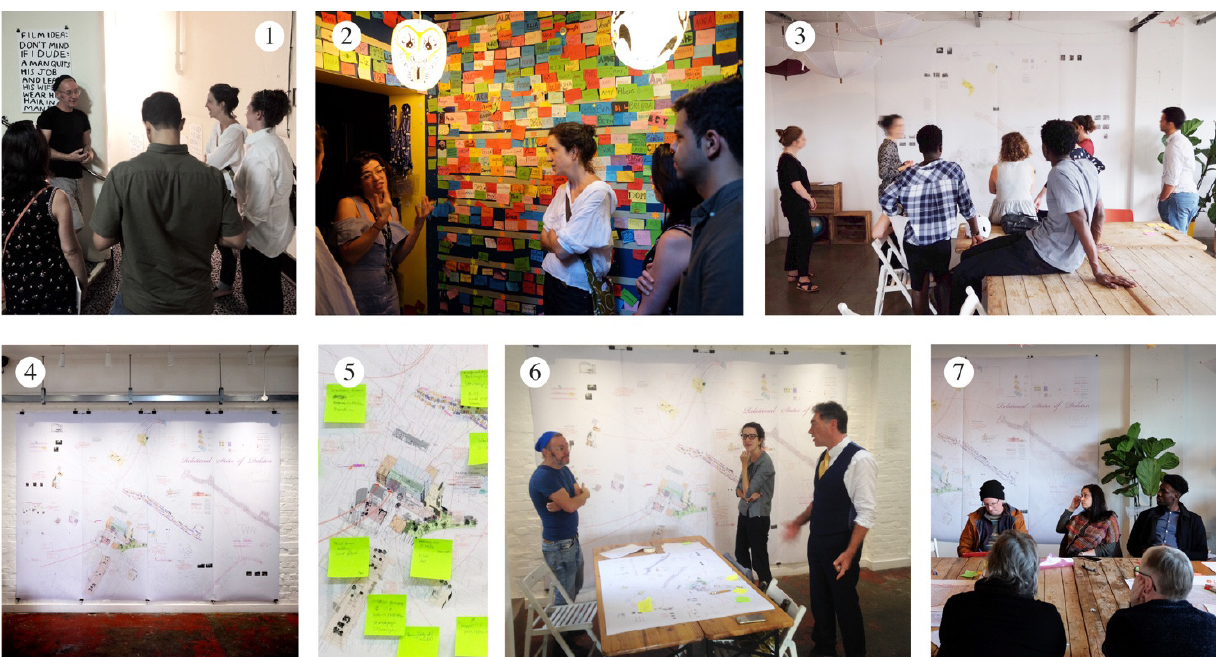
Figure 5. Documentation of engagement during the mapping process: The student researcher team interviews stakehold‐ ers, September 2018 (1 and 2); interim review with LBH in Dalston, September 2018 (3); public exhibition at Bootstrap Gallery, October and November 2018 (4); feedback workshops with stakeholders, October 2018 (5 and 6); the student